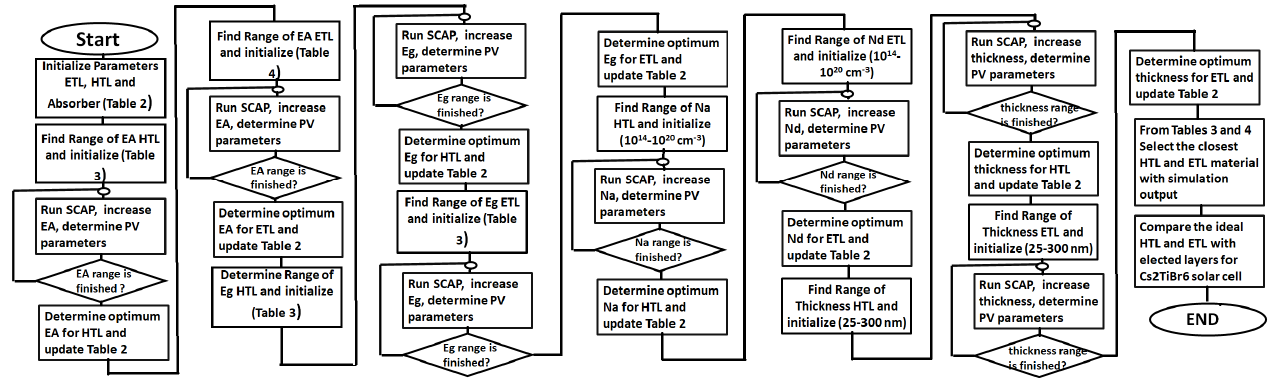
Figure 2. Flowchart used in this study to estimate the ideal hole transport layer (HTL) and electron transport layer (ETL) properties for Cs 2 TiBr 6 -based perovskite solar cell.